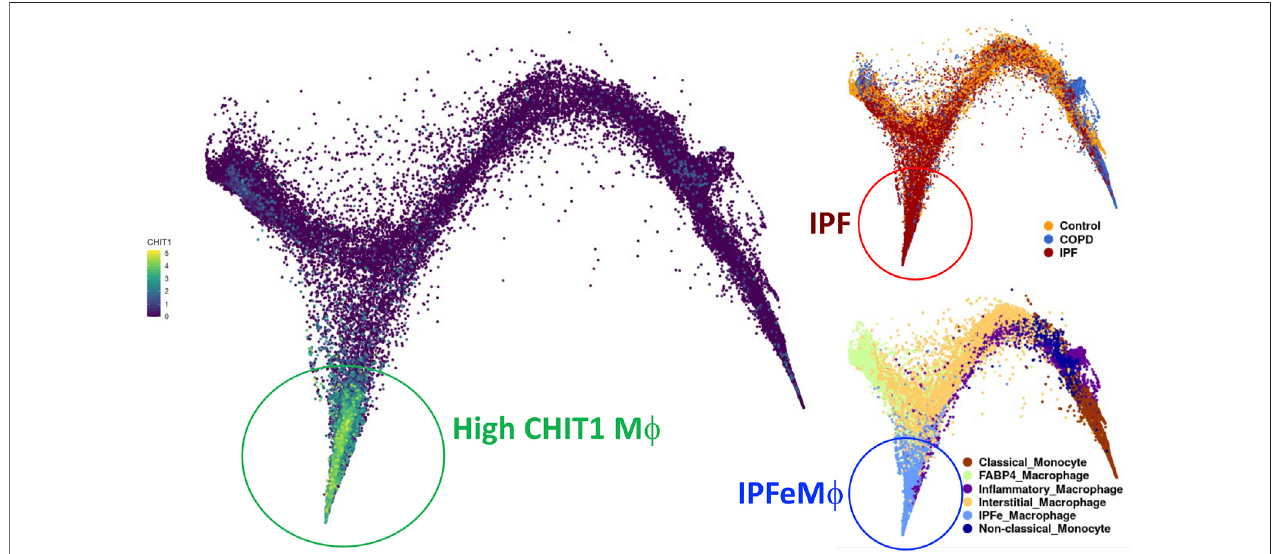
FIGURE 1 | UMAP (uniform manifold approximation and projection) clustering of lung macrophages in patients with IPF evaluated by single cell RNAseq analysis. Highly CHIT1 expressingmacrophages (green, left) are overlapping with macrophage subset of patients with IPF (dark brown, upper right) but not with control or COPD patients (blue or bright brown, right upper). It is also notable that most of these CHIT1 expressing macrophages are signi fi cantly overlapping with IPF expanded macrophages (IPFeM ϕ ) (Blue, right lower), the distinct subset of pro fi brotic macrophages noted in IPF patients. Publicly available RNAseq data (http://www. ipfcellatlas.com/; Single cell RNA-seq, 2021, Ivan Rosas group) was re-plotted for CHIT1 expressing